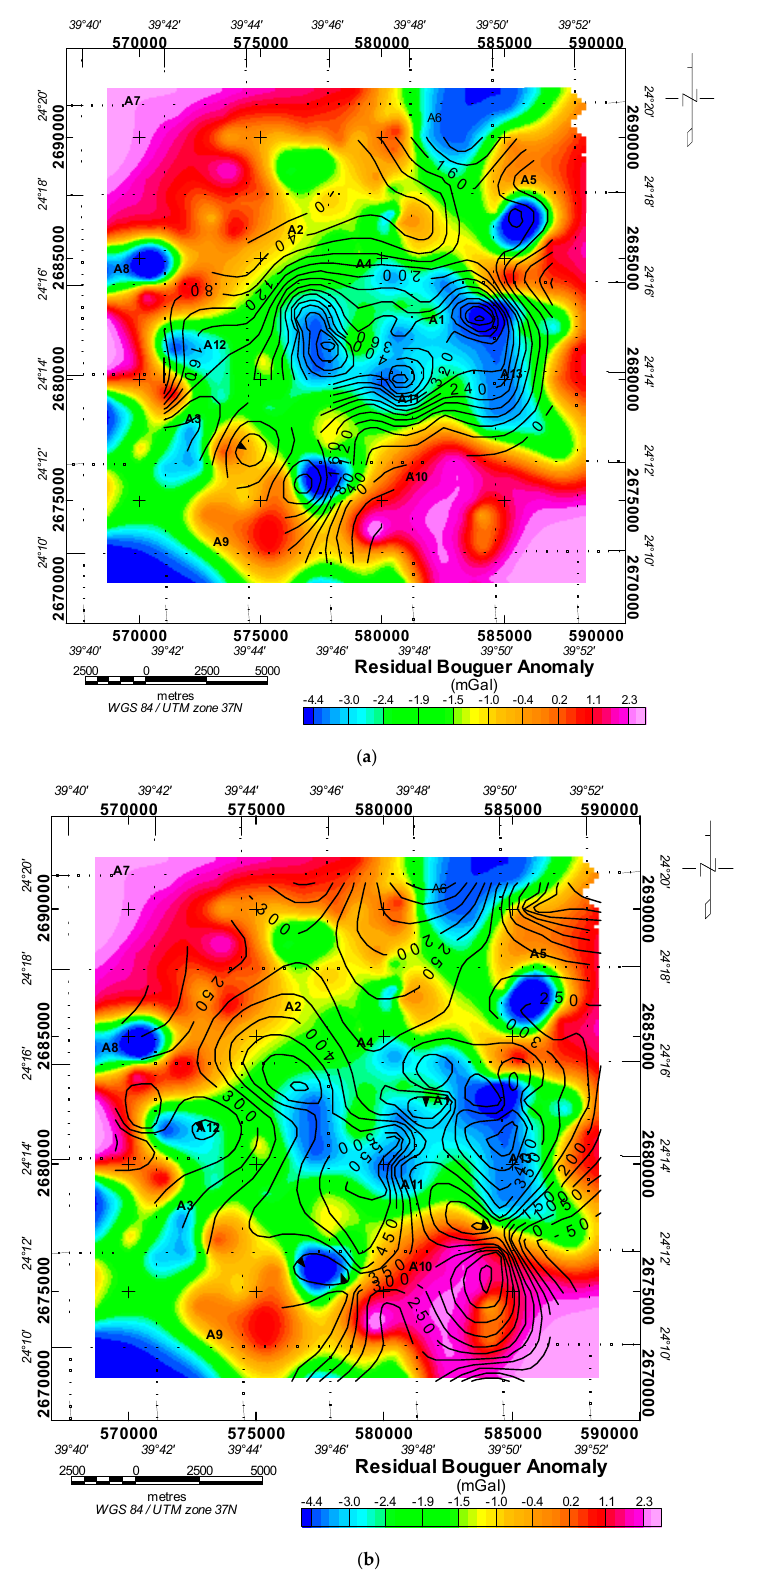
Figure 13. ( a ) The contour plot of the depths (m) to basement realized from the PSO computations superimposed on the residual gravity anomaly map of the region.( b ) The contour plot of the depths (m) to basement realized from the GM modeling computations superimposed on the residual gravity anomaly map of the region.